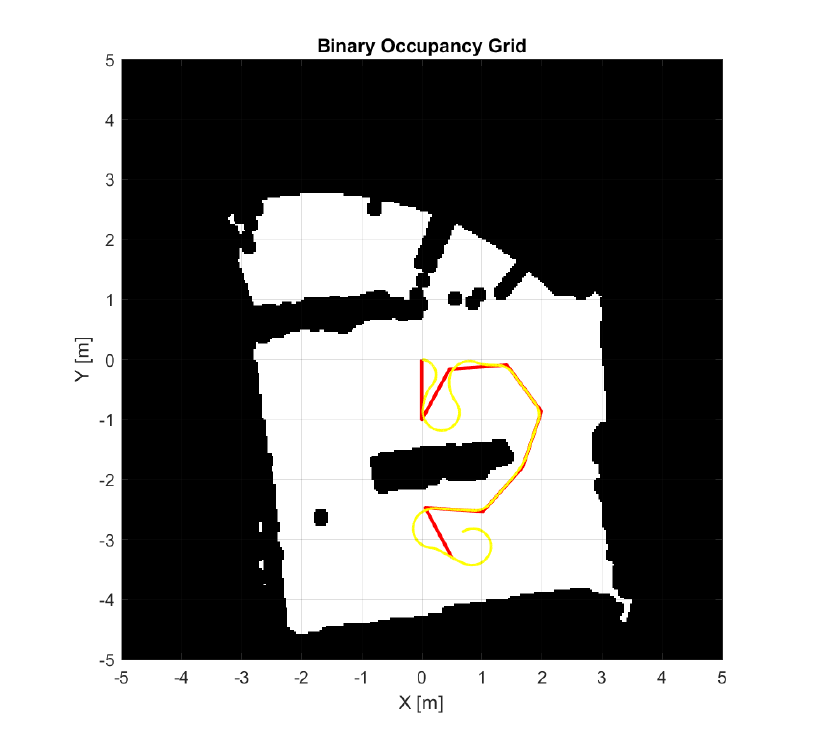
Figure 15. Desired waypoints obtained with HybridA star algorithm and path obtained from odometry data.